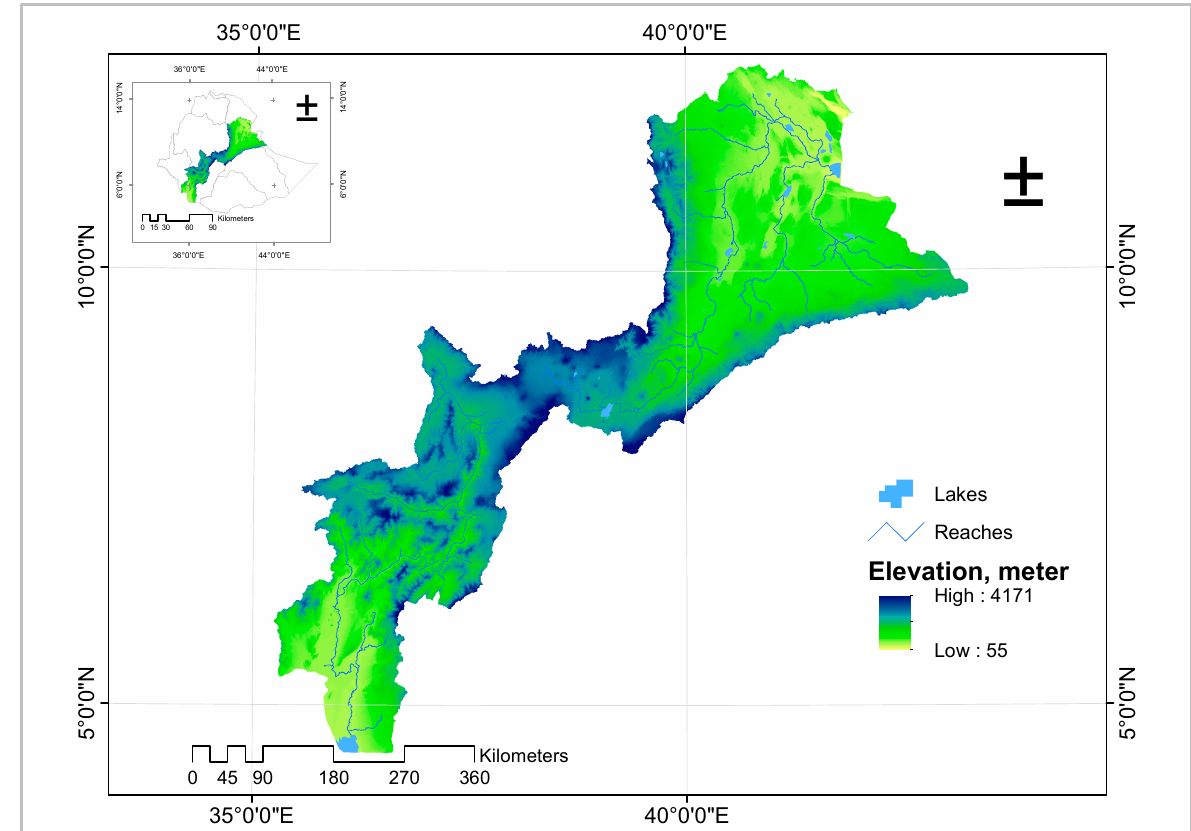
Figure 1. Study area location and surface features.